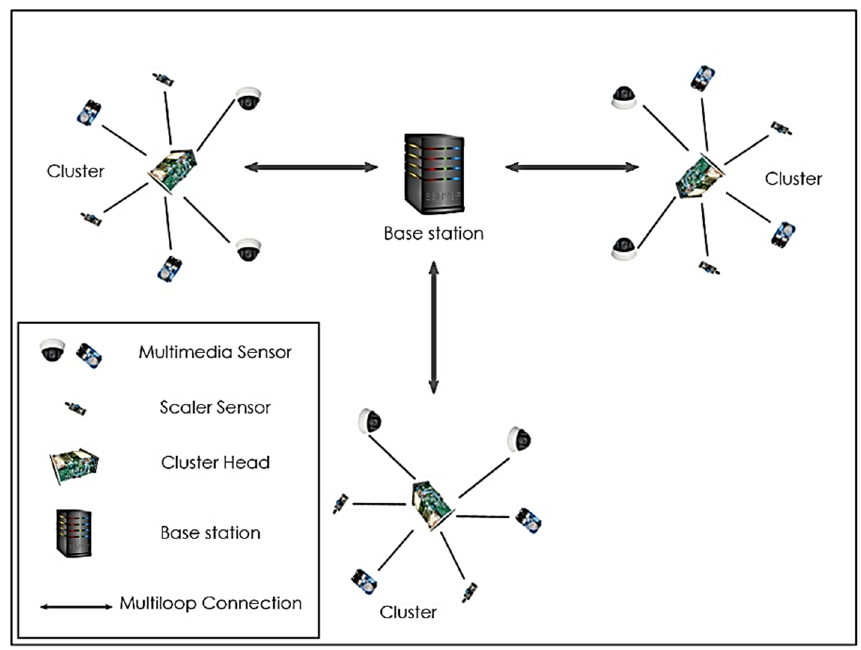
Figure 2. Clustered architecture.